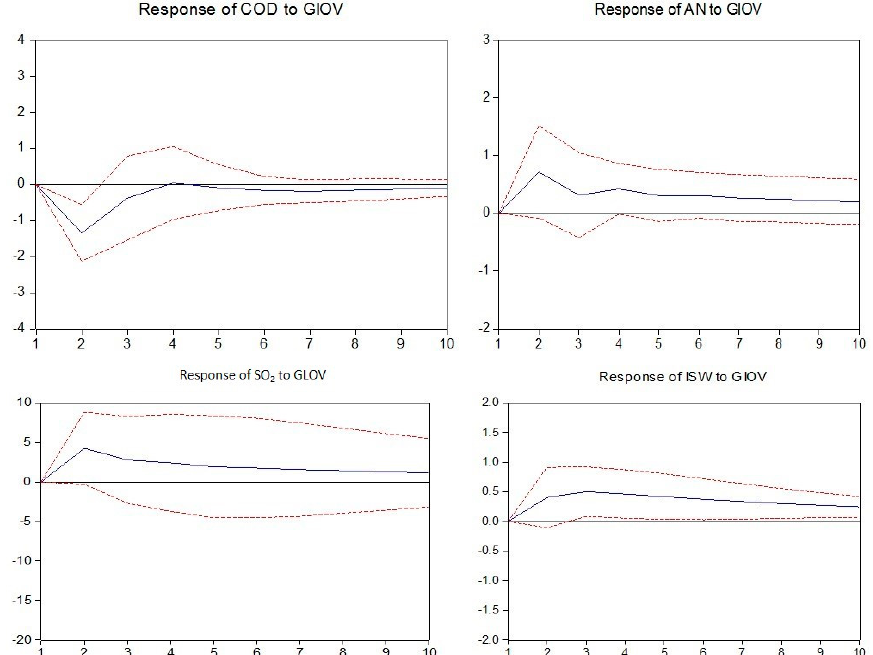
Figure 10. Responses of pollutants charged to industrial output value of mining and processing of non-ferrous metal ores. The solid lines indicate the mean responses to a one standard deviation shock, while the dotted lines represent ± 2 standard deviations of the responses.